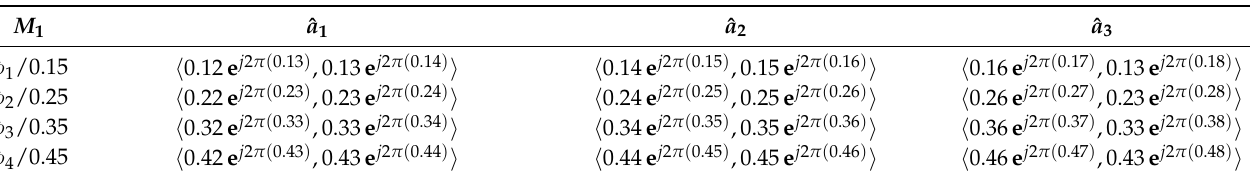
constructed with Dm 1 Dm 1